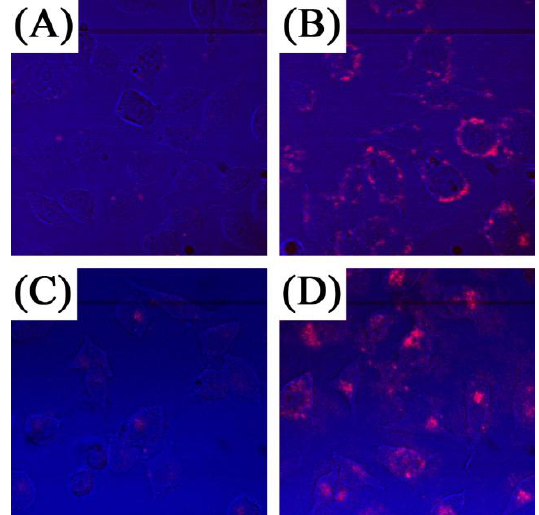
Figure 13. Confocal images of Panc 1 cells treated with up-conversion NPs ( A , B ) and down-conversion NPs ( C , D ). ( A ) and ( C ) show non-bioconjugated nanophosphors, ( B ) and ( D ) show cells targeted with nanophosphors conjugated with anti-claudin 4 and anti-mesothelin, respectively ([124], reproduced by permission of